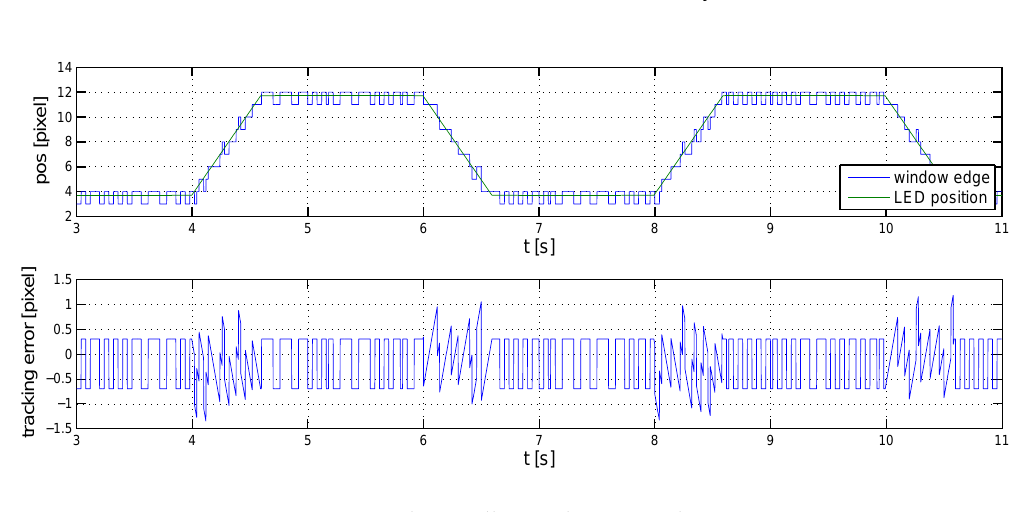
Figure 10. Fine-tuned controller, nonlinear